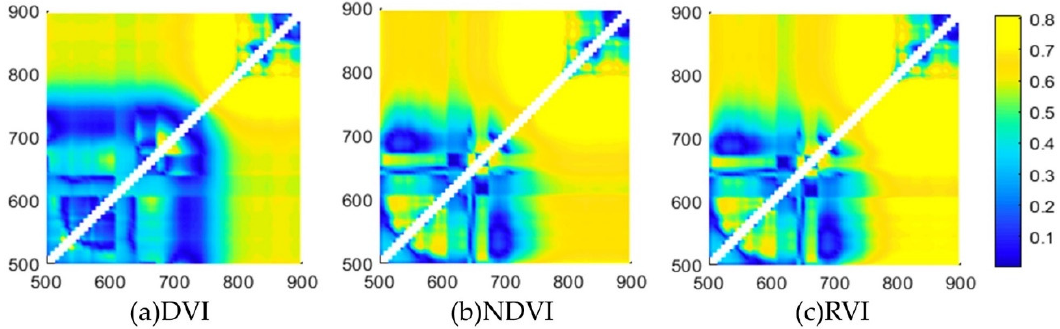
Figure 5. The R 2 maps between AGB and ( a ) DVI, ( b ) NDVI, and ( c ) RVI.